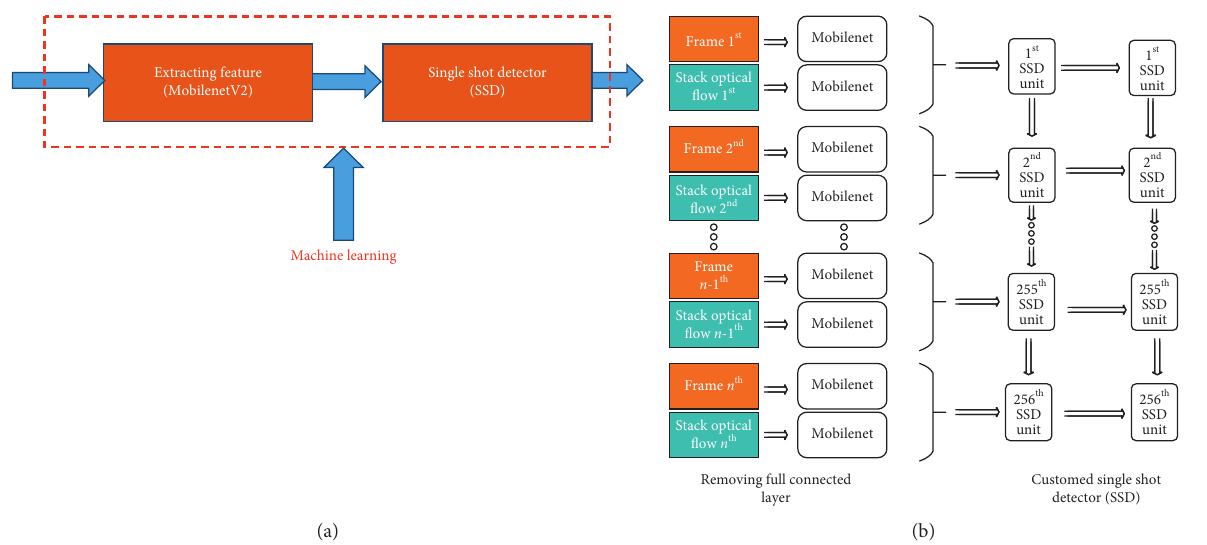
Figure 2: Proposal recognition module of gesture using CNN: (a) overview and (b) detail of the